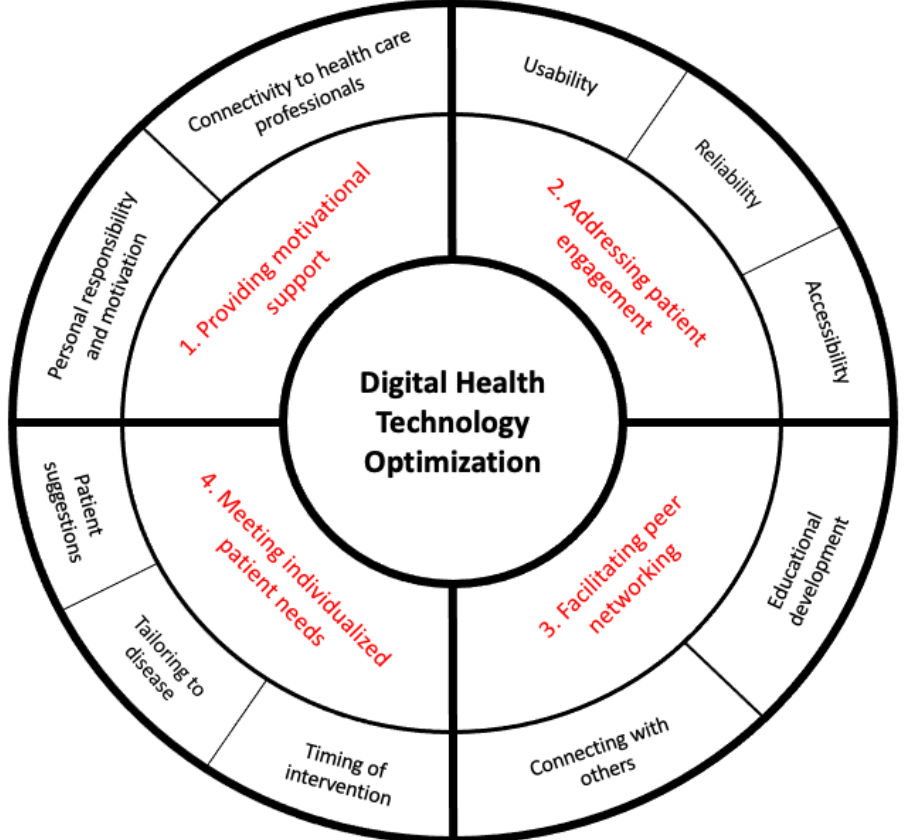
Figure 2. Developed themes and subthemes for Digital Health Technology Optimization. The inner band on the diagram (red text) represents the 4 overarching themes developed by this review, and the outer band details the subsequent subthemes (black